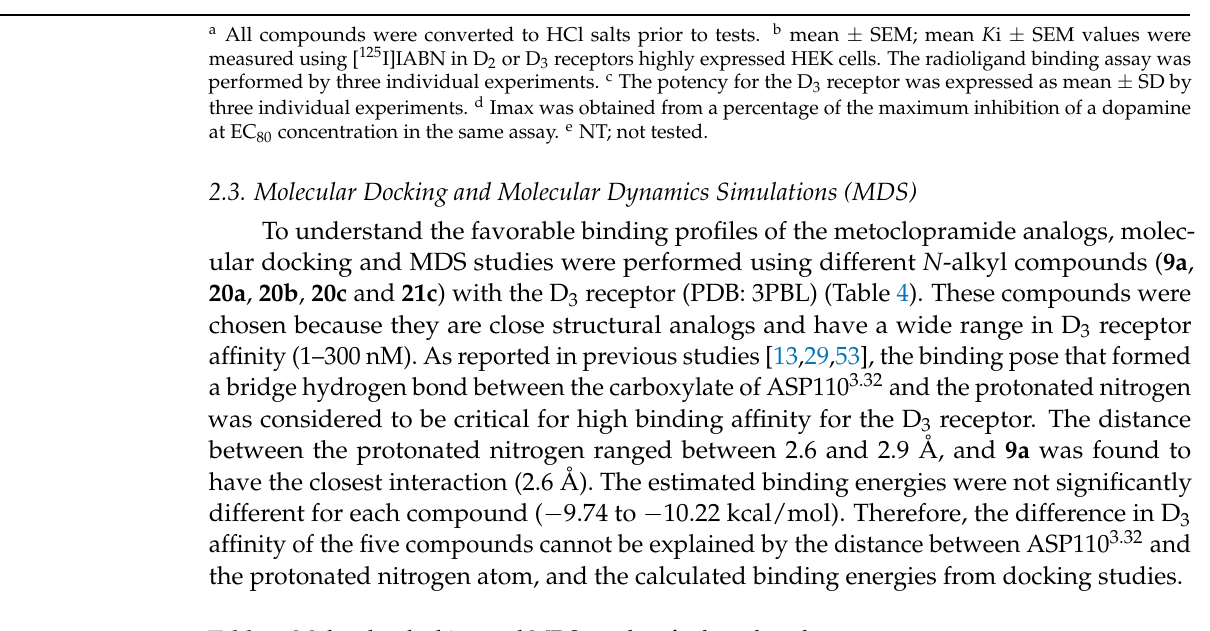
Table 4. Molecular docking and MDS results of selected analogs. Cmpd fallypride